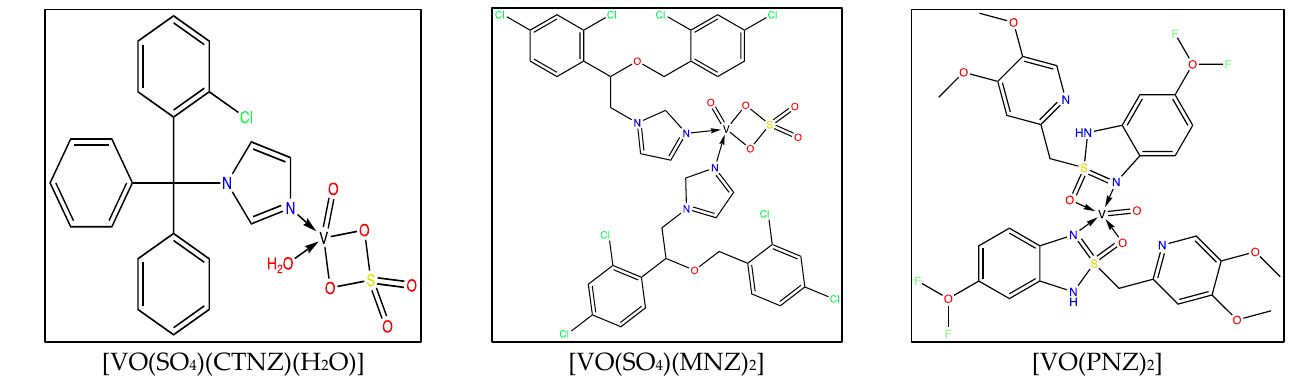
Figure 1. Suggested structures of synthesized oxidovanadium(IV) complexes.